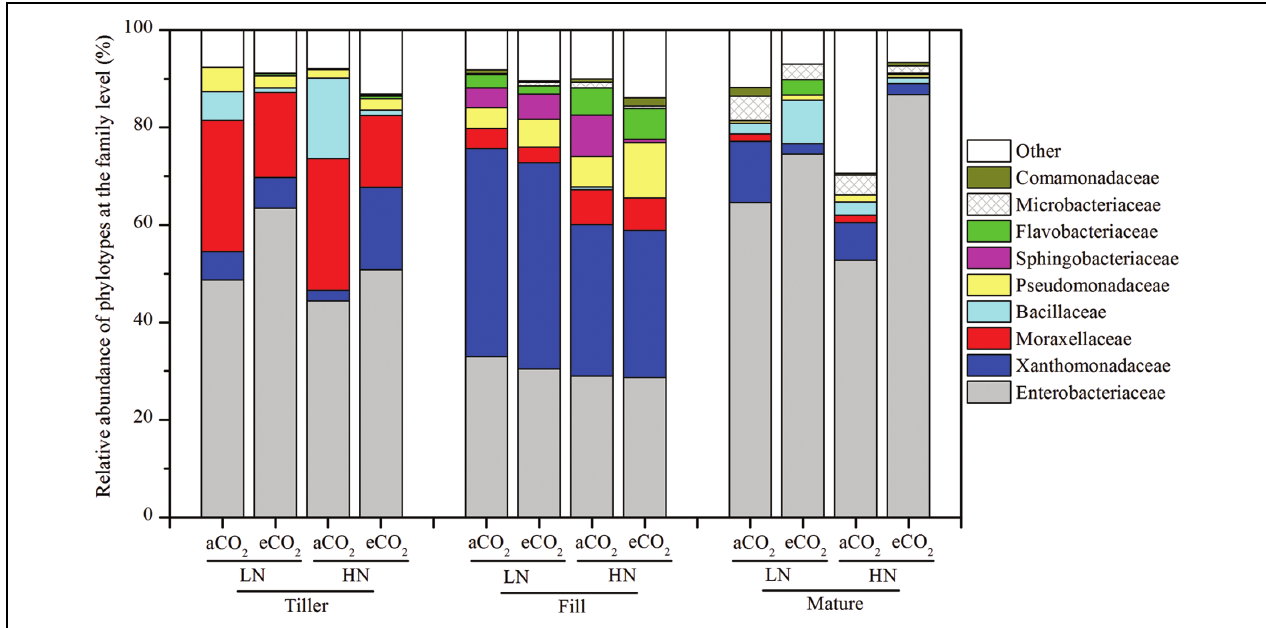
FIGURE 1 | The relative abundance of the leaf endophytic bacterial phylotypes at the family level. The designations Tiller, Fill, and Mature indicate that the rice leaves were sampled at the tillering, filling, and maturity stages, respectively. The aCO 2 and